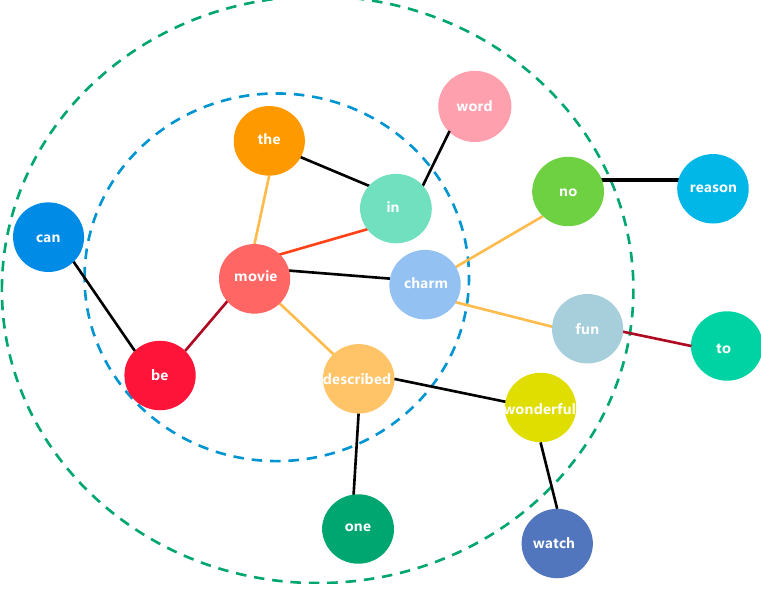
Figure 1. Text Graph.